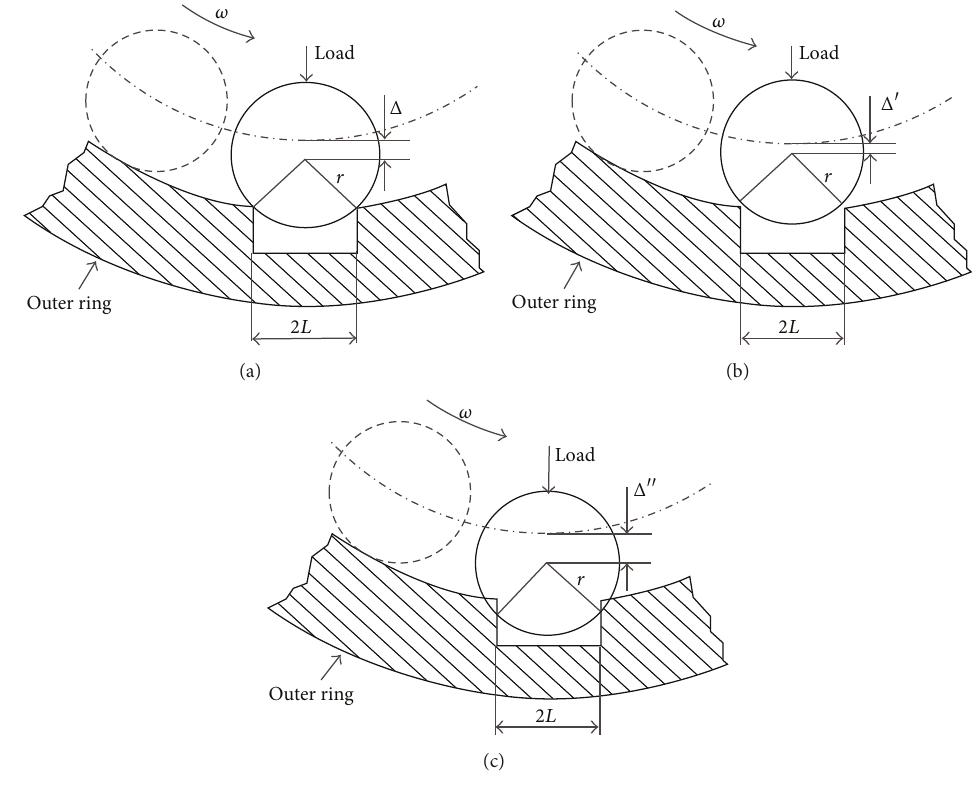
Figure 1: The sinking depth of the